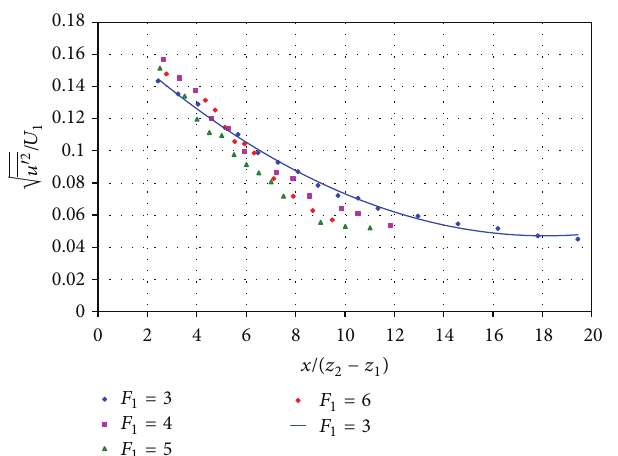
Figure 2: Turbulence intensity along free hydraulic jump. Figure 3: Maximum velocities below hydraulic jumps near the floor for 𝐹 1 ≥ 4 .